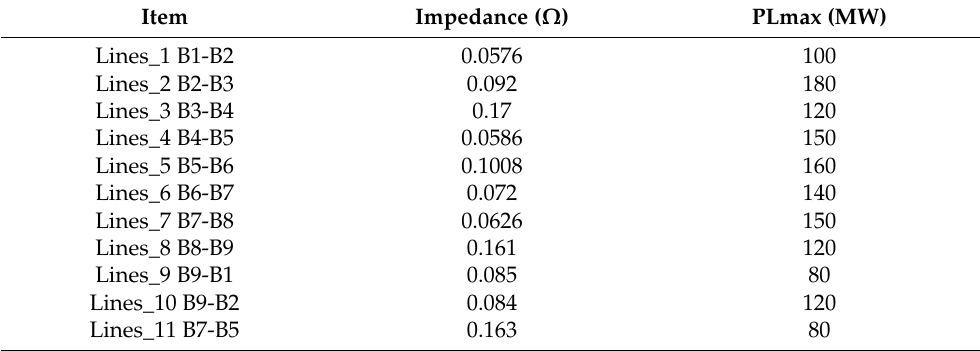
Table A3. Parameters of 9-bus system.